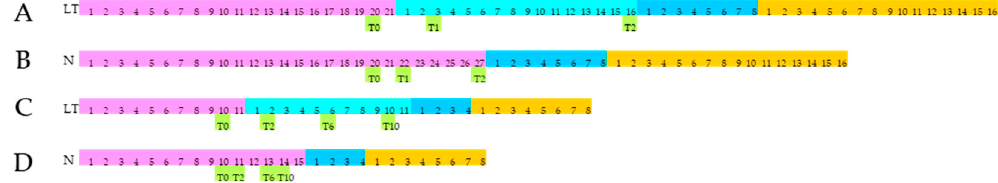
Figure 1. Scheme of the experiments and samplings. RNA-sequencing (RNA-seq) experiments ( A ): low temperature (LT) treatment and ( B ): control (N), nursery in magenta, low temperature in cyan, freezing in sky blue, and recovery period in orange; quantitative polymerase chain reaction (qPCR) experiments from Reference [28], as mentioned in § 2.5 , ( C ): LT and ( D ): N, color codes as in RNA-seq. The sampling dates are in green and the numbers refer to the days.